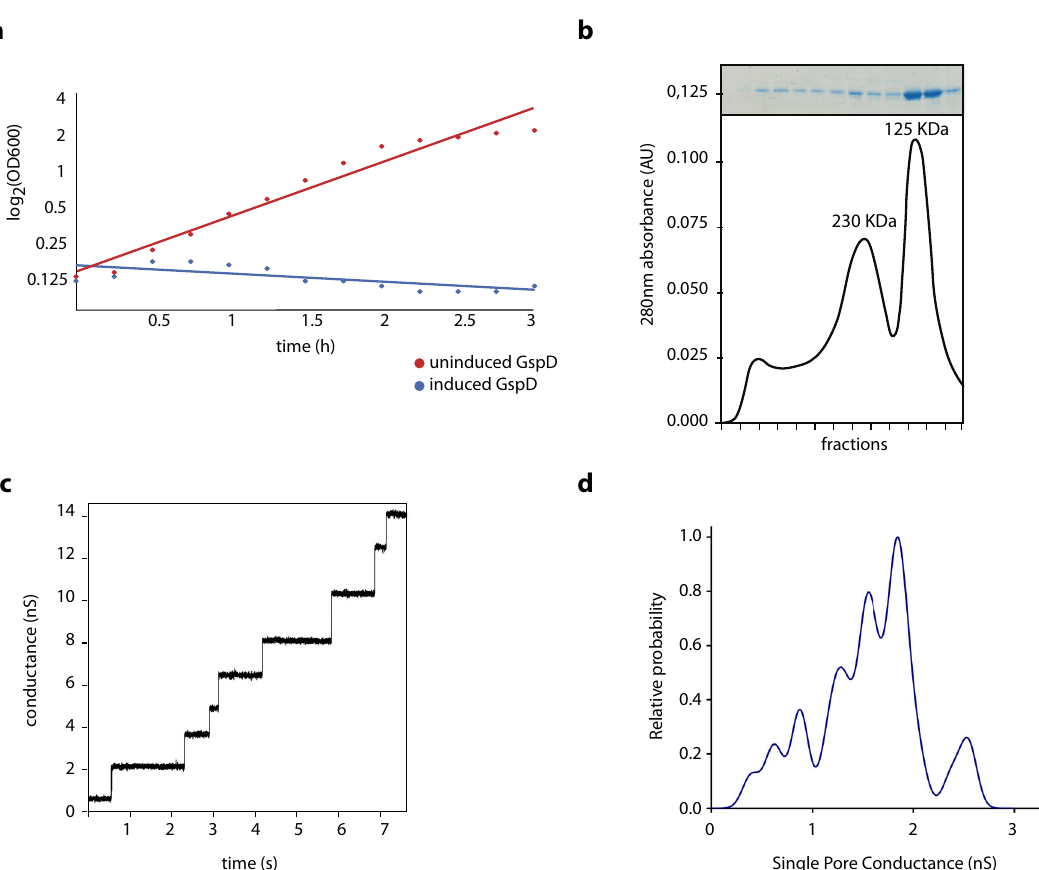
Fig. 5 Membrane pore formation of mitochondrial GspD. a Expression of mitochondrial Ng GspD in bacteria quickly causes cell death upon induction. b Size exclusion chromatography of Ng GspD shows two peaks of putative GspD complexes (bottom) and SDS – PAGE of the corresponding fractions (top). c Single channel recording of the Ng GspD complex. The applied membrane potential was 15 mV. d Histogram of different recorded amplitudes during channel opening indicates multiple types of Ng GspD-formed pores in the membrane (For a – d , representative images of three experiments are